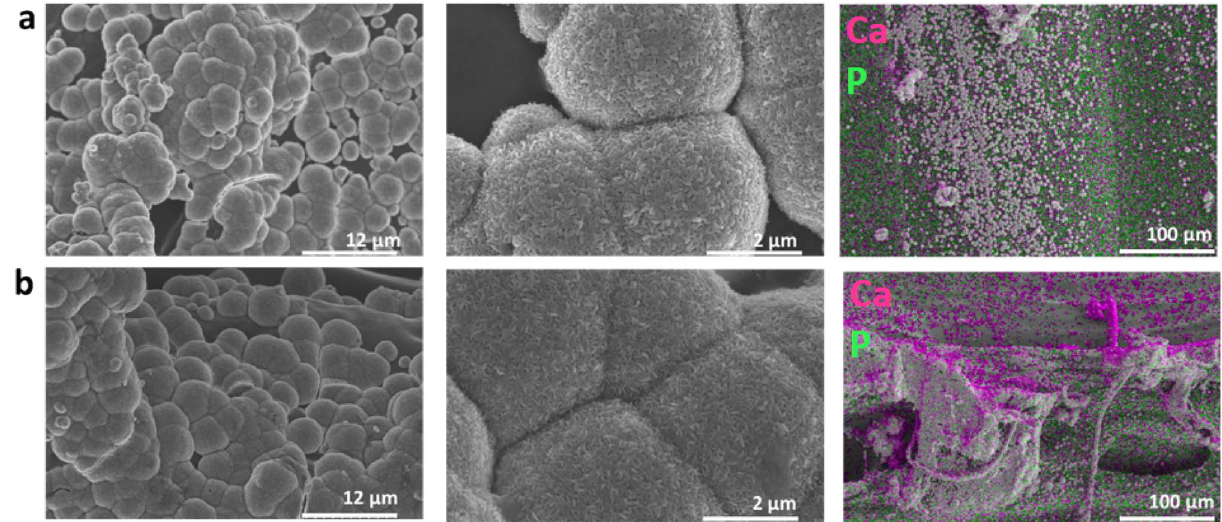
Figure 6. Evaluation of the apatite growth on PLA and PLA/CNC3 scaffolds mineralized in SBF at 14 days by scanning electron microscopy at high and low magnification (SEM) to validate the formation of the inorganic layer and by elemental mapping to show the presence and homogeneous distribution of the phosphate and calcium elements that constitute the apatite. ( a ) SEM images and elemental mapping of PLA, ( b ) SEM images and elemental mapping of